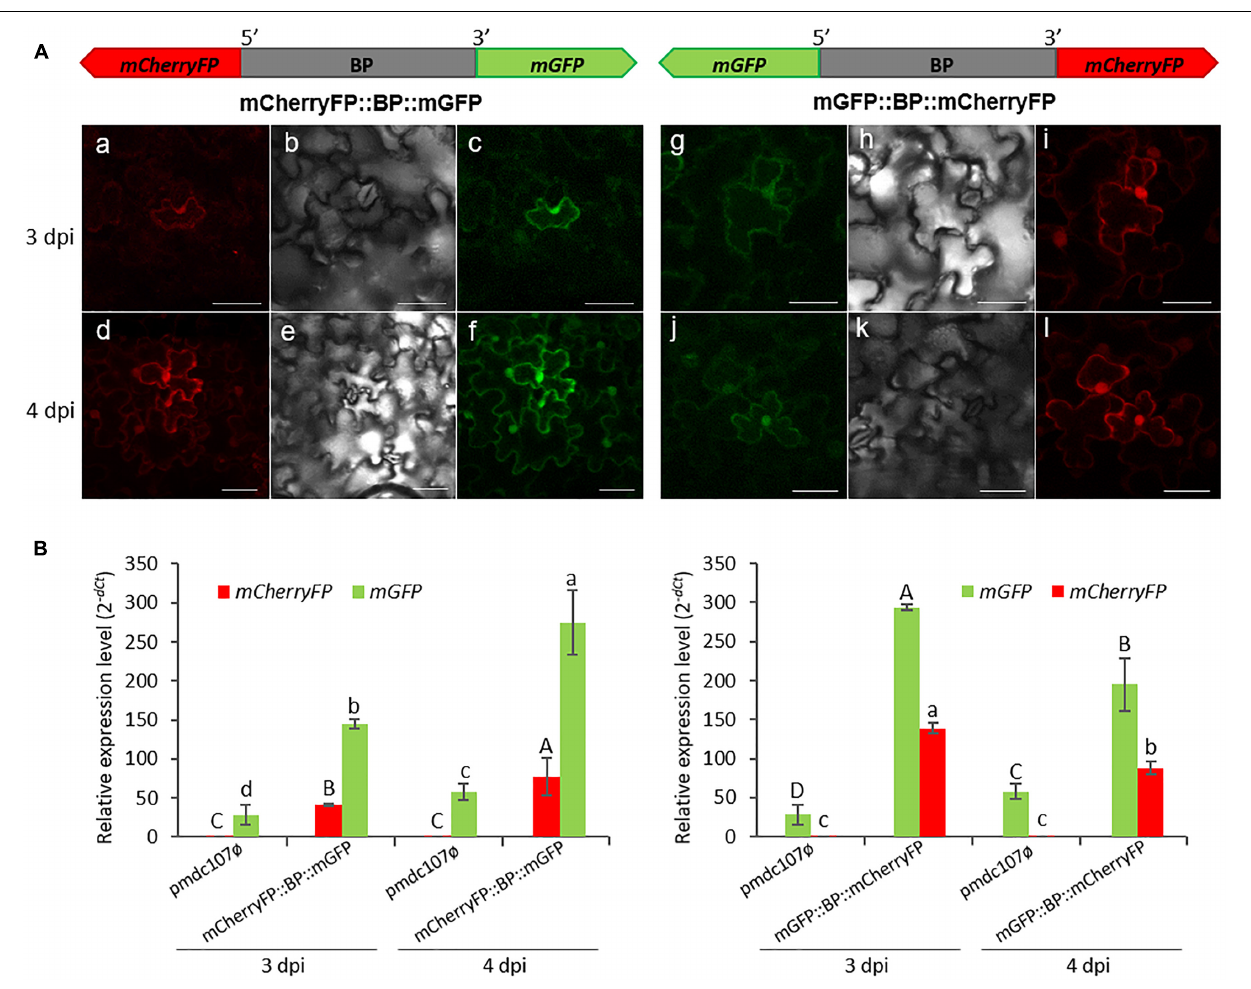
FIGURE 3 | Schematic representation of fusion-constructs and transient expression assays in N. benthamiana leaves. (A) Scheme of mCherryFP and mGFP genes under the bidirectional promoter (BP) and confocal stacks spanning tobacco epidermal cells of transient transformed leaves at 3 and 4 post-infiltration days (dpi). Projections are from mCherryFP (a,d,i,l) , mGFP (c,f,g,j) and the corresponding Nomarski snap-shots (b,e,h,k) . Scale bars represent 50 µ m. (B) Relative expression levels (2 − dCt ) of mCherryFP and mGFP genes in agroinfiltrated N. benthamiana leaves with the control vector (pmdc107ø) or with the constructs including the bidirectional promoter fused to the two reporter genes. Data are means ± SE of three replicates. Different letters indicate significant differences ( P < 0.05 Wald χ 2 followed by LSD test). Primers used for this experiment are listed in Supplementary Table 1